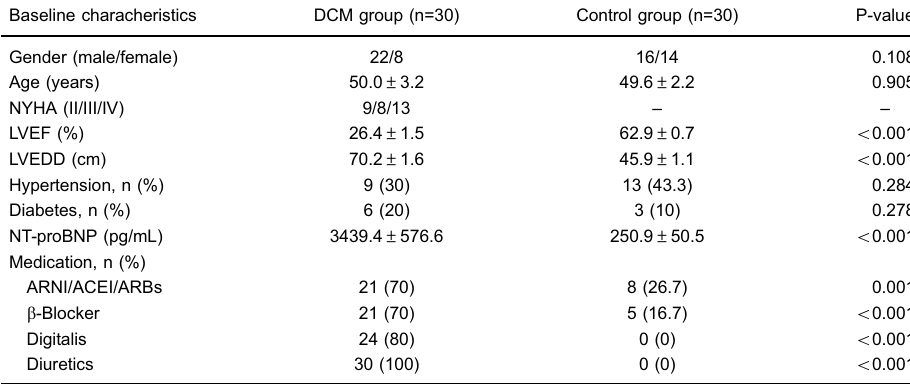
Table 2. Baseline characteristics of all enrolled